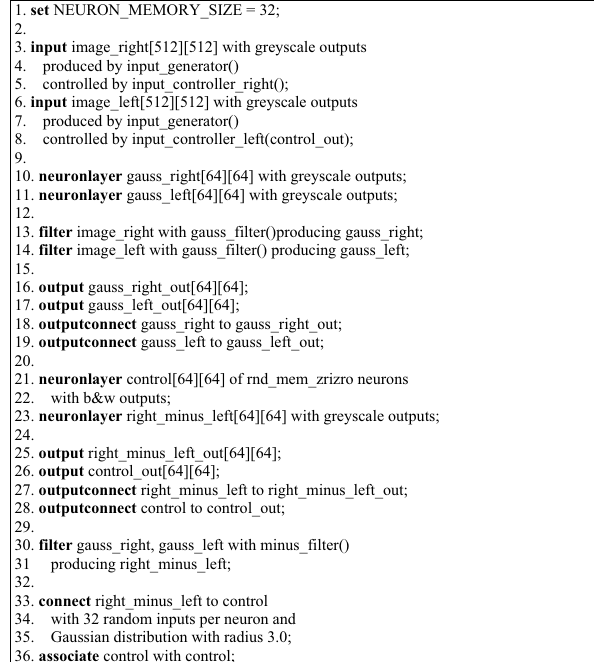
Figure 9 NADL specification of Figure 1